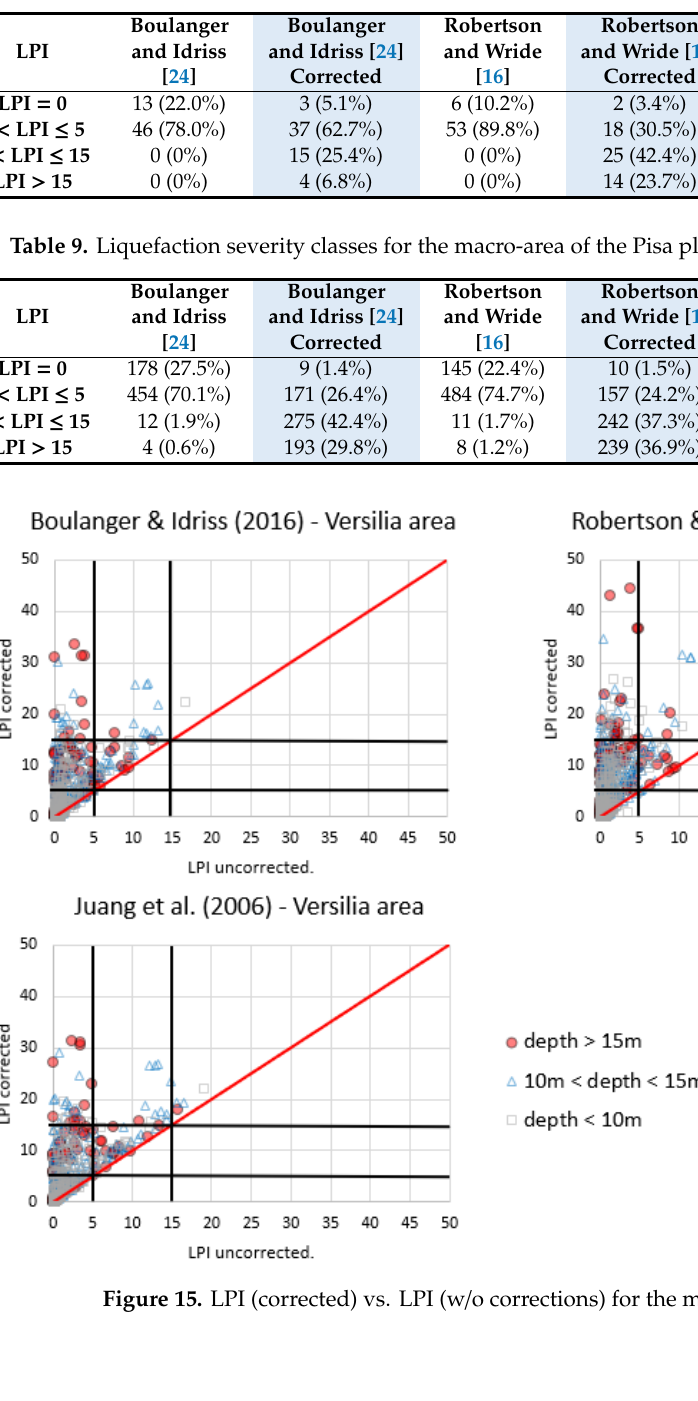
Figure 16. LPI (corrected) vs. LPI (w/o corrections) for the macro-area of the Lucca plain.